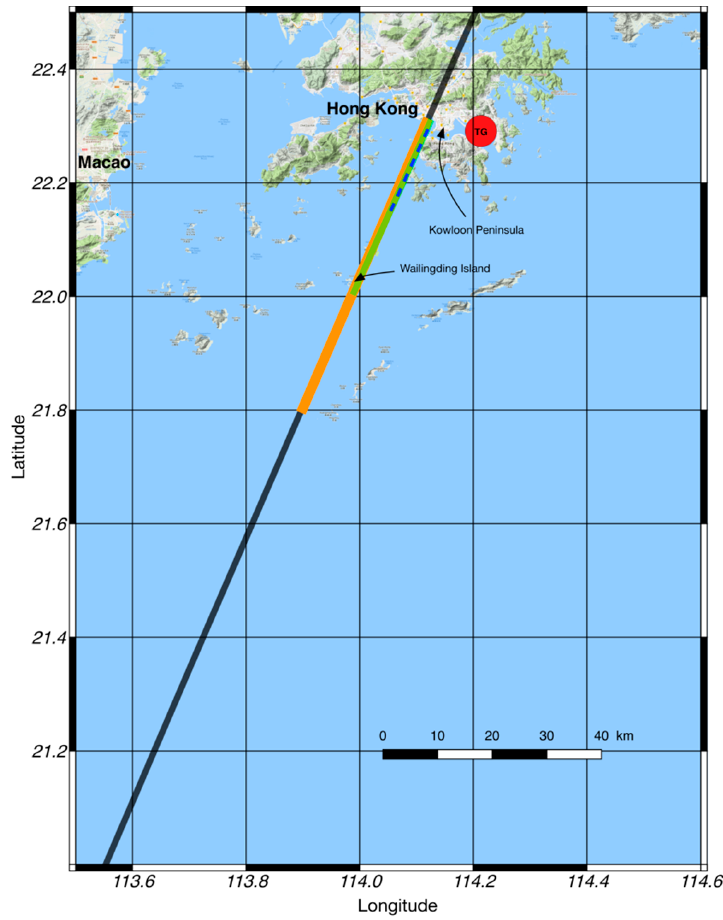
Figure 2. Map showing the study area, the selected Jason-2 pass 153 (black and colored line) and the Quarry Bay tide gauge (red circle). The latter is located ~10 km away from the Jason-2 pass. The along-track sections corresponding to study cases 1, 2, and 3 are also indicated (orange, green, and blue-green dashed lines, respectively). The background map is from Google Earth.